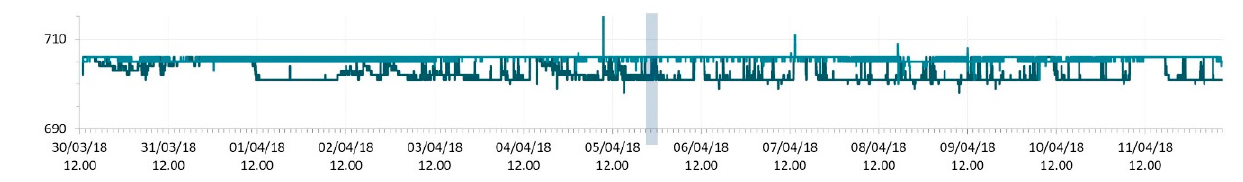
Figure 7. Raw patterns of valve openings of two individuals of P. casertanum included in the first study group, from 30 March 2018 to 12 April 2018: HUB03-01 in blue colour, HUB03-02 in heavenly colour.